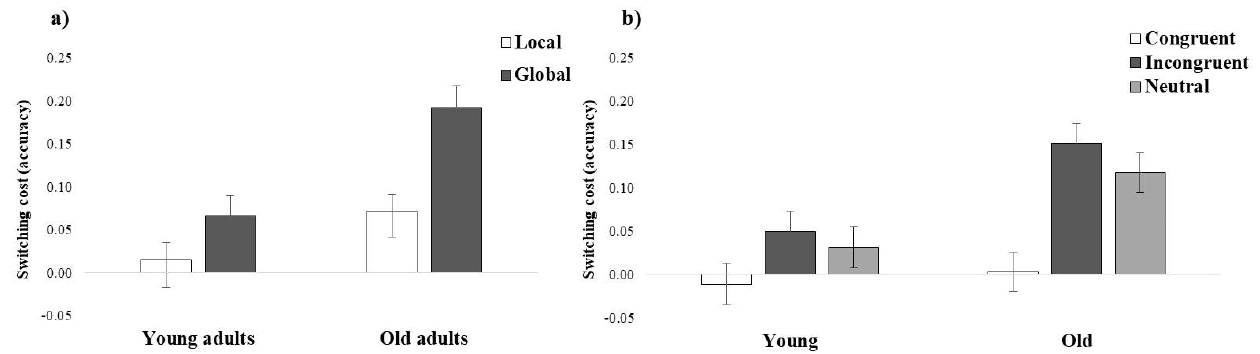
Figure 1. Mixing cost in accuracy (proportion, i.e., non-switching trials minus switching trials) ob- tained in the global-local task as a function of ( a ) group and condition, and ( b ) group and congru- ence.